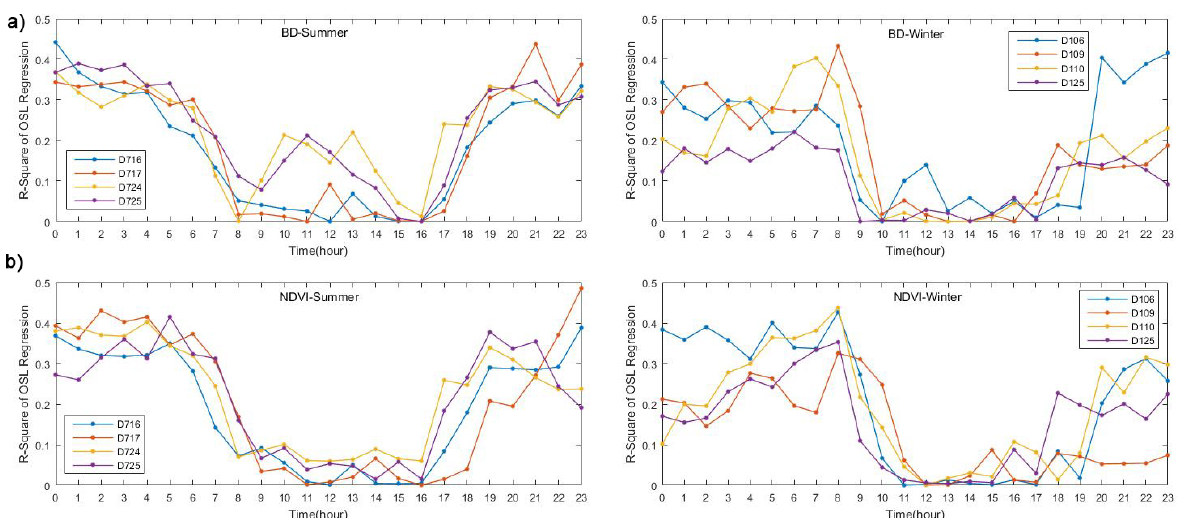
Fig 6. R 2 of Hourly regressions in summer and winter: a) R 2 for BD-AT regression in summer and winter; a) R 2 for NDVI- AT regression in summer and